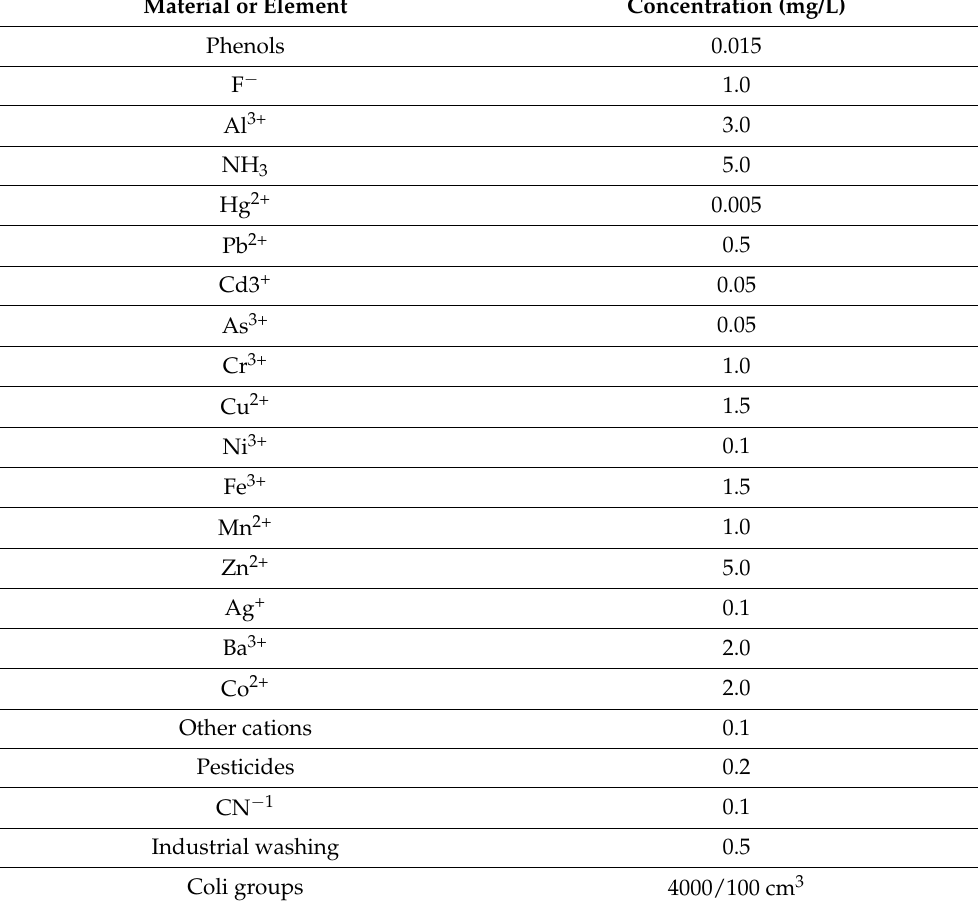
Table 3. The chemical construction of sewage